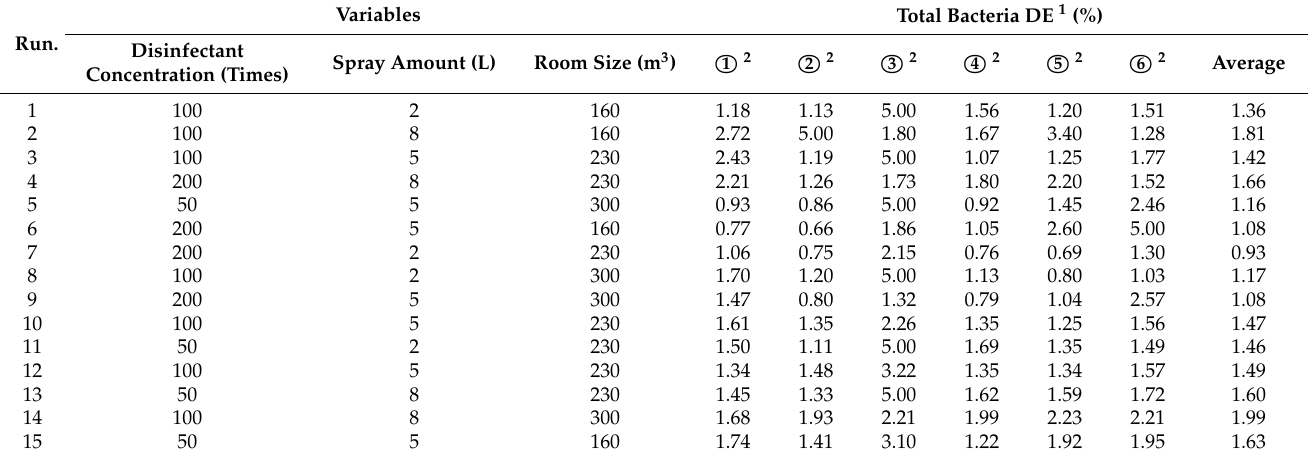
Table 2. Box–Behnken design with the experimental values and disinfection efficiency for the total bacteria in each experiment.